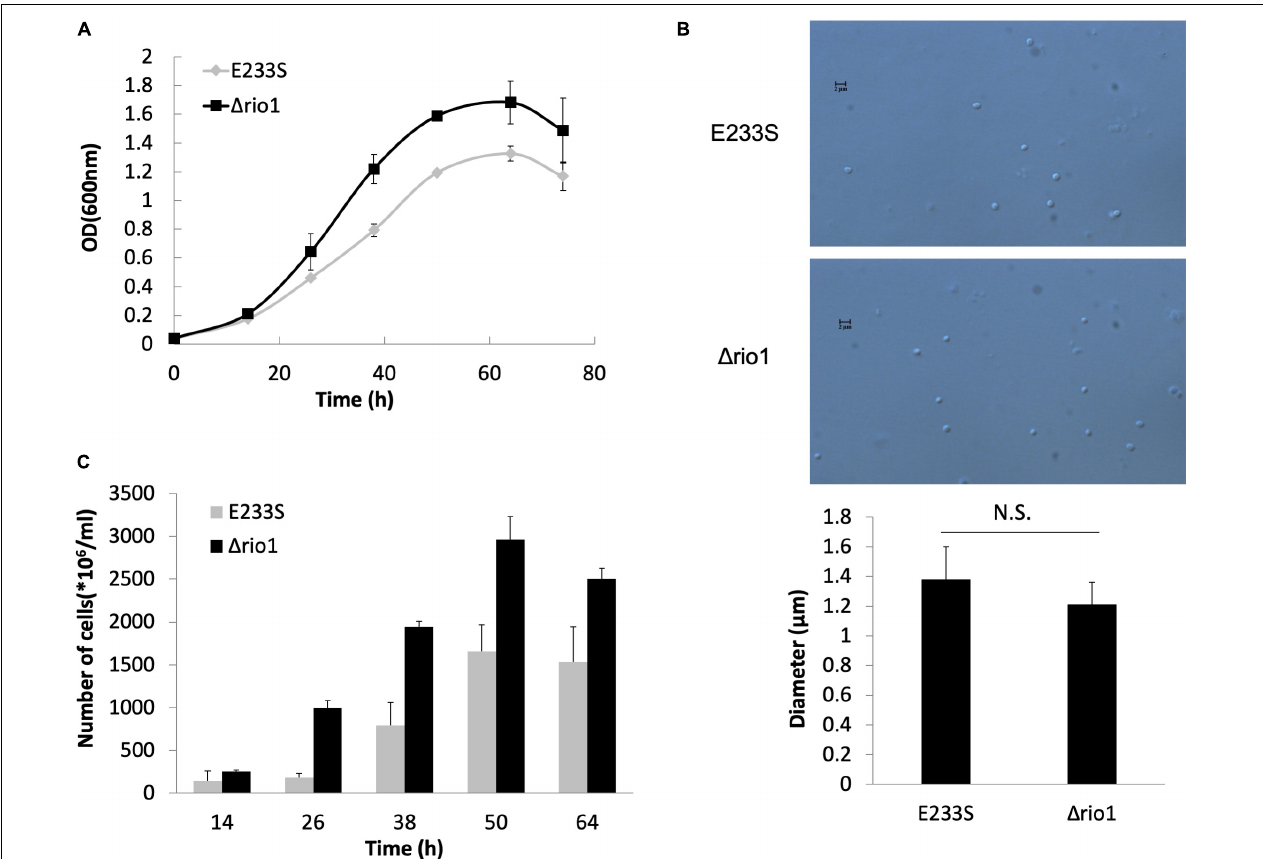
FIGURE 1 | (cid:49) rio1 grew faster than the wild type strain E233S. (A) Growth curves of (cid:49) rio1 and E233S. The cultures were transferred to fresh medium at a same initial OD 600 value. Samples were taken at an interval of 6 or 12 h for measuring ODs until stationary phase. (B) Cell size of (cid:49) rio1 and E233S. The samples at early log phase (OD 600 ∼ 0.2) were used for microscopy. Diameters of 190–200 cells were measured for each strain and the averages are shown at the bottom. Representative photos are shown. Scale bar (2 µ m) is indicated. N.S., non-significant. (C) Colony formation assay of (cid:49) rio1 and E233S. Samples of the two strains were taken at same time point during their growth and diluted for plating. Colonies were counted after 7–10 days incubation at 75 ◦